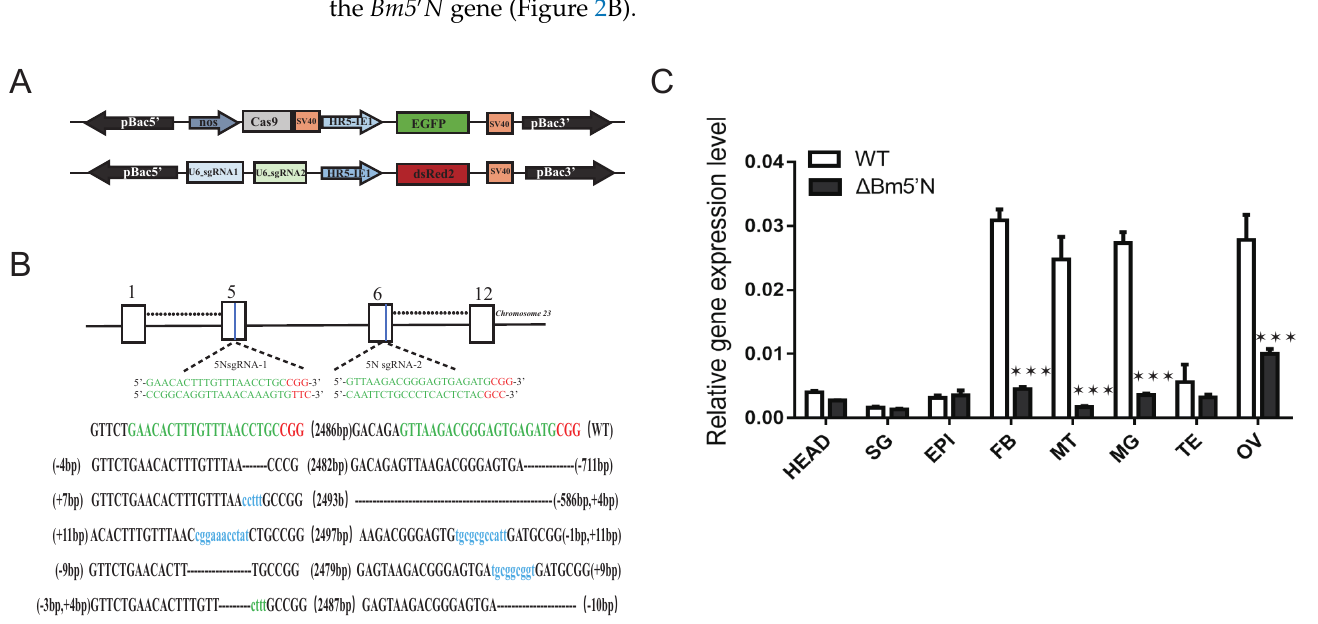
Figure 2. Construction of ∆ Bm5 (cid:48) N mutants using the CRISPR/Cas9 genome editing system ( A ) Constructs for piggyBac- based transgenic transformation. Expression of Cas9 is driven by a nos promoter with EGFP as a fluorescent marker. Expression of the two Bm5 (cid:48) N sgRNAs under the control of U6 promoter is indicated by DsRed2. ( B ) Bm5 (cid:48) N gene structure and sgRNA-target sites. Boxes denote the 13 exons of this gene. Bm5 (cid:48) N-specific sgRNA target sites are located in exons five and six. The sgRNA-targeting sequences are in green, and the adjacent protospacer motif (PAM) sequences are in red. The deletion mutations in Bm5 (cid:48) N in selected mutants are shown. ( C ) Relative Bm5 (cid:48) N mRNA expression in eight tissues of ∆ Bm5N mutant and WT. Abbreviations: head (HEAD), silk gland (SG), epidermis (EPI), fat body (FB), Malpighian tubule (MT), testis (TE), ovary (OV). Three biological replicates were performed; error bars denote ± SD. The asterisks (***) indicate significant differences relative to WT ( p < 0.001, t